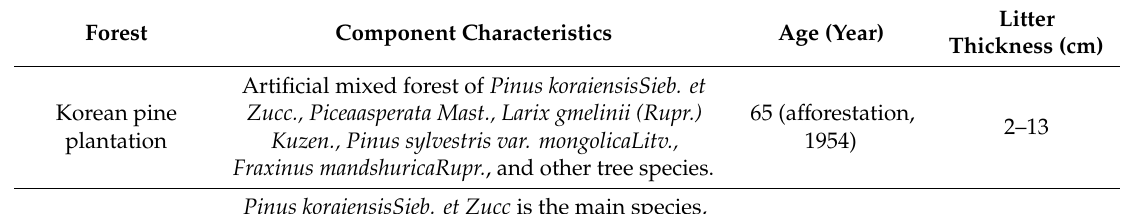
Table 1. Introduction of terraced